Question: Write the caption for this figure.
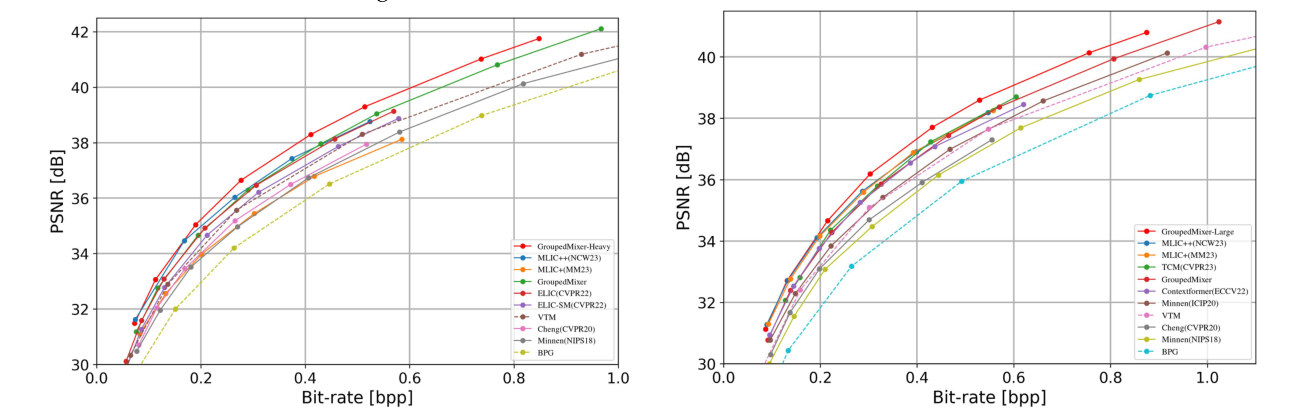
Answer: Performance evaluation on the CLIC’21 Test dataset.